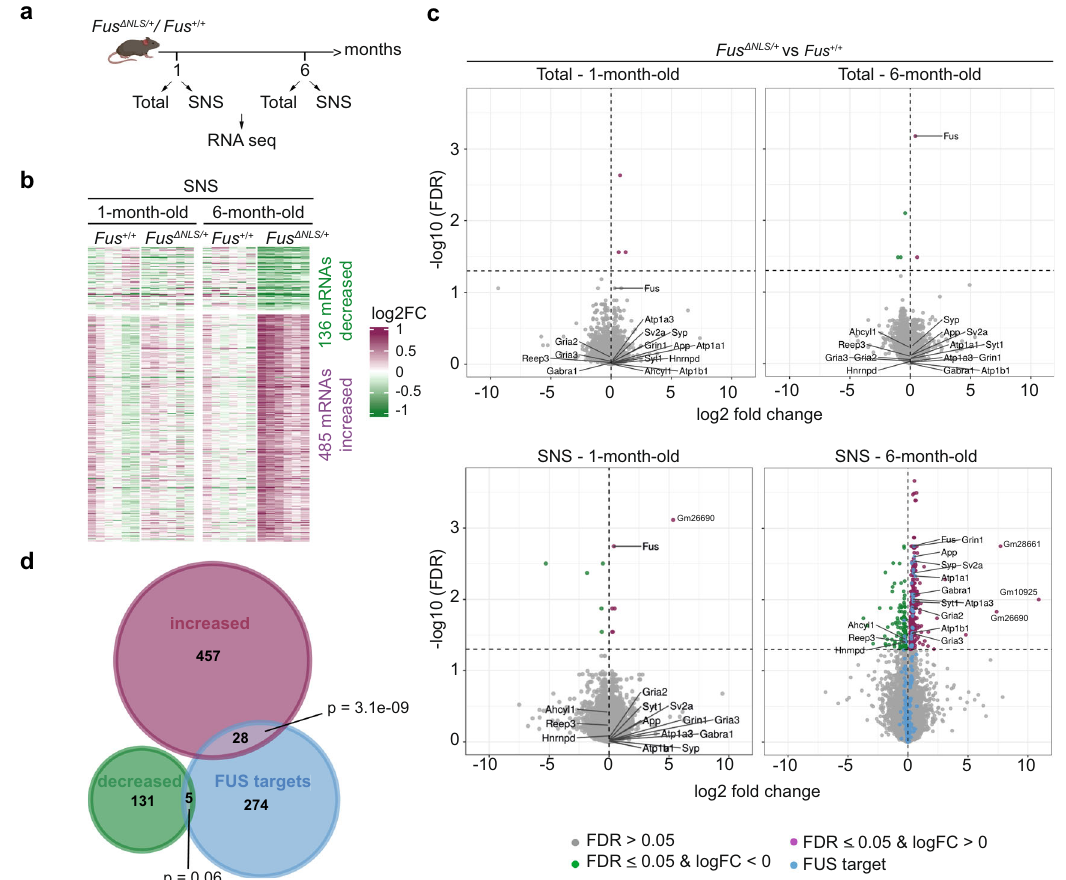
Fig. 4 Age-dependent alterations in the synaptic mRNA pro fi le of Fus Δ NLS/ + mouse cortex. a Outline of the RNA-seq experiment. b Heatmap from the set of increased and decreased mRNAs in synaptoneurosomes of Fus Δ NLS/ + at 6-months compared to Fus + / + . mRNAs are on the rows and the different samples on the columns. The color scale indicates the log2FC between the CPM of each sample and mean CPM of the corresponding Fus + / + samples at each time point [sample logCPM – mean (logCPM of Fus + / + samples)]. c Volcano plots showing the log2 fold change of each mRNA and the corresponding minus log10 (FDR) of the differential gene expression analysis comparing total cortex and synaptoneurosomes from Fus Δ NLS/ + to Fus + / + at 1 month (left panel) and 6 months of age (right panel). The horizontal line marks the signi fi cance threshold of 0.05. Signi fi cantly decreased mRNAs are highlighted in green, increased mRNAs in purple and all FUS targets identi fi ed in the CLIP-seq data in blue. d Euler diagram of the sets of signi fi cantly increased and decreased mRNAs (synaptoneurosomes of Fus Δ NLS/ + vs. Fus + / + at 6 months of age) and the synaptoneurosomes FUS targets identi fi ed by CLIP-seq. The p -values indicated the enrichment of FUS targets among the increased/decreased mRNAs (one-sided Fisher ’ s exact